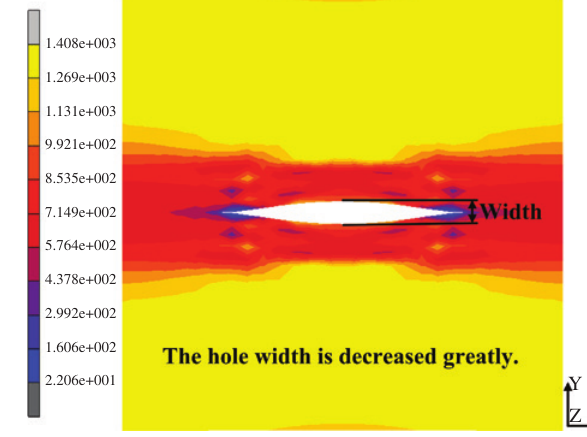
Figure 15: X -component stress distribution of the cell after the middle spring is removed.